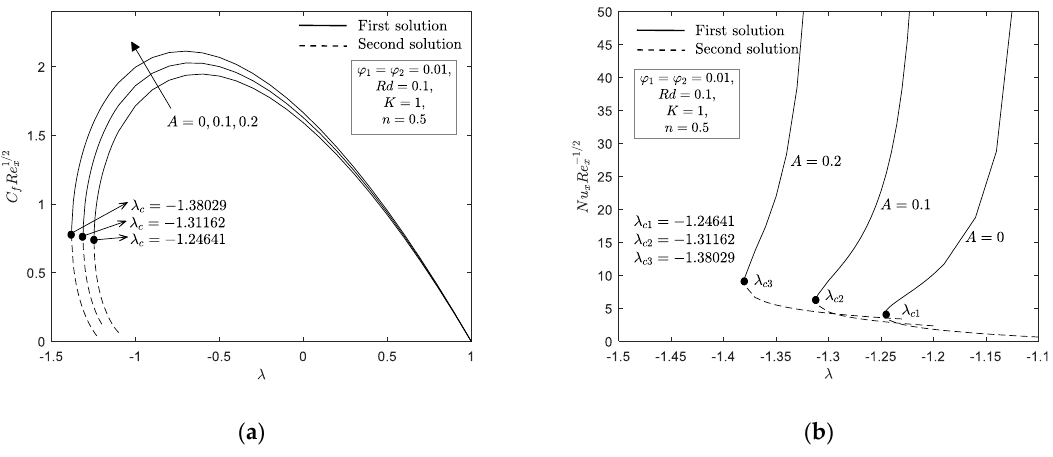
− 1/2 x with λ for various A